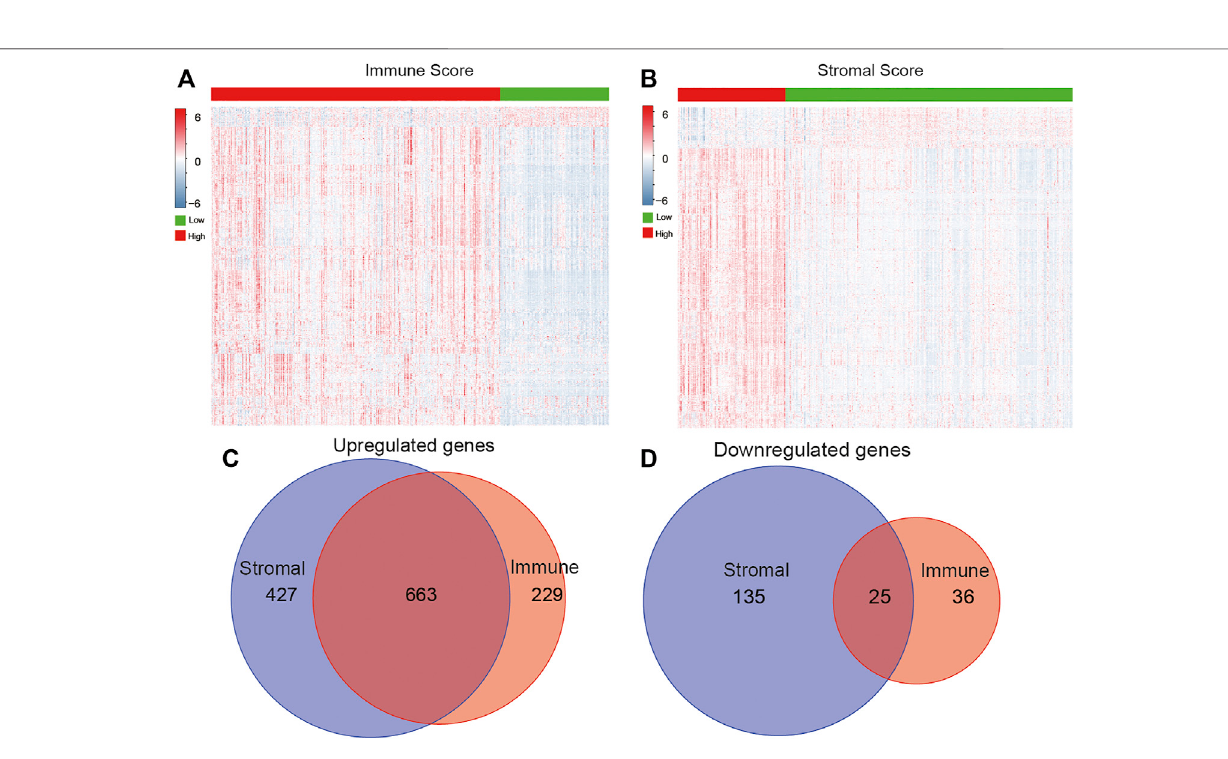
upregulated and 160 downregulated DEGs according to the comparison between high stromal score ( n (cid:1) 132) and low stromal score ( n (cid:1) 355) groups ( Figure 3B ). Venn diagrams